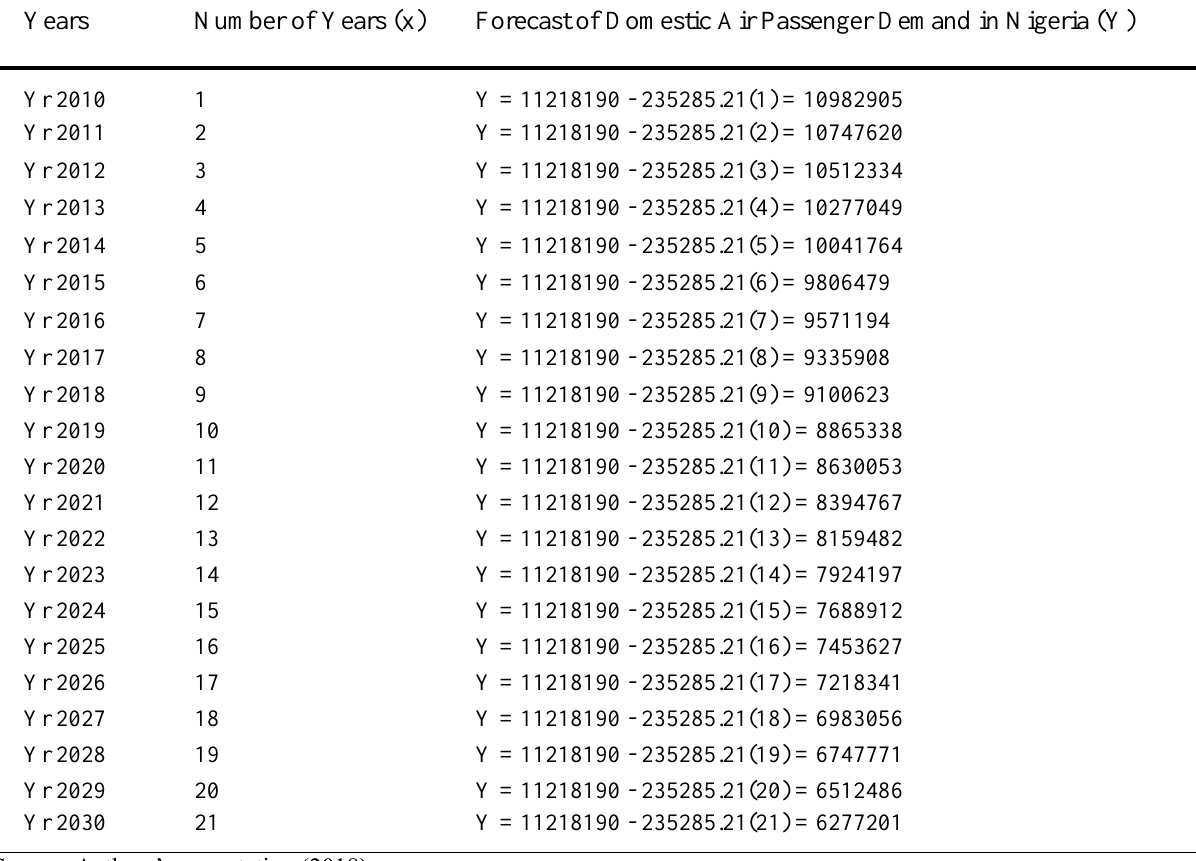
Table 3. Determination of Domestic Air Passenger Demand Forecast in Nigeria.